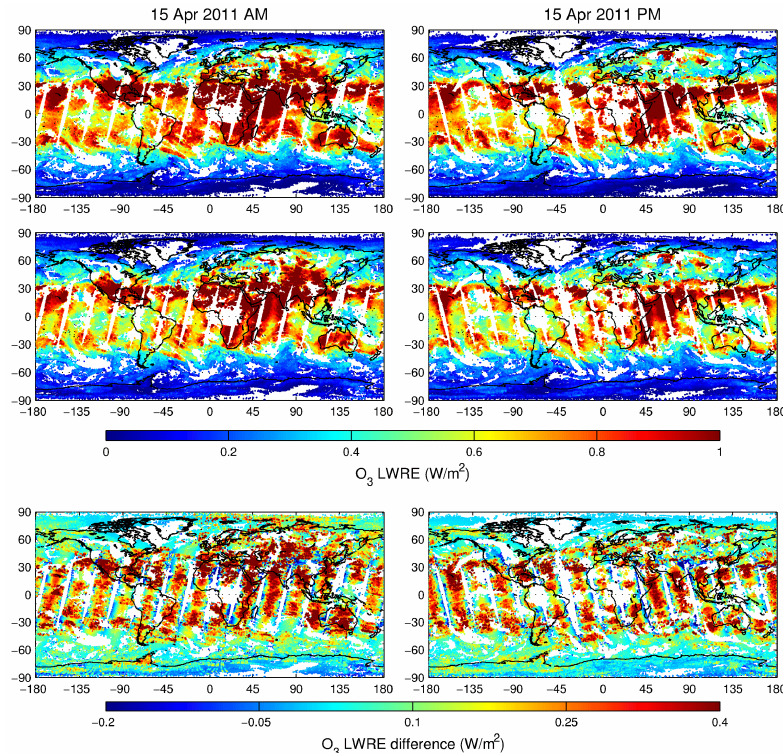
Figure 5. Same as Fig. 4 but for the tropospheric O 3 LWRE. The calculation of the tropospheric LWRE relies on the definition of the tropopause by the WMO